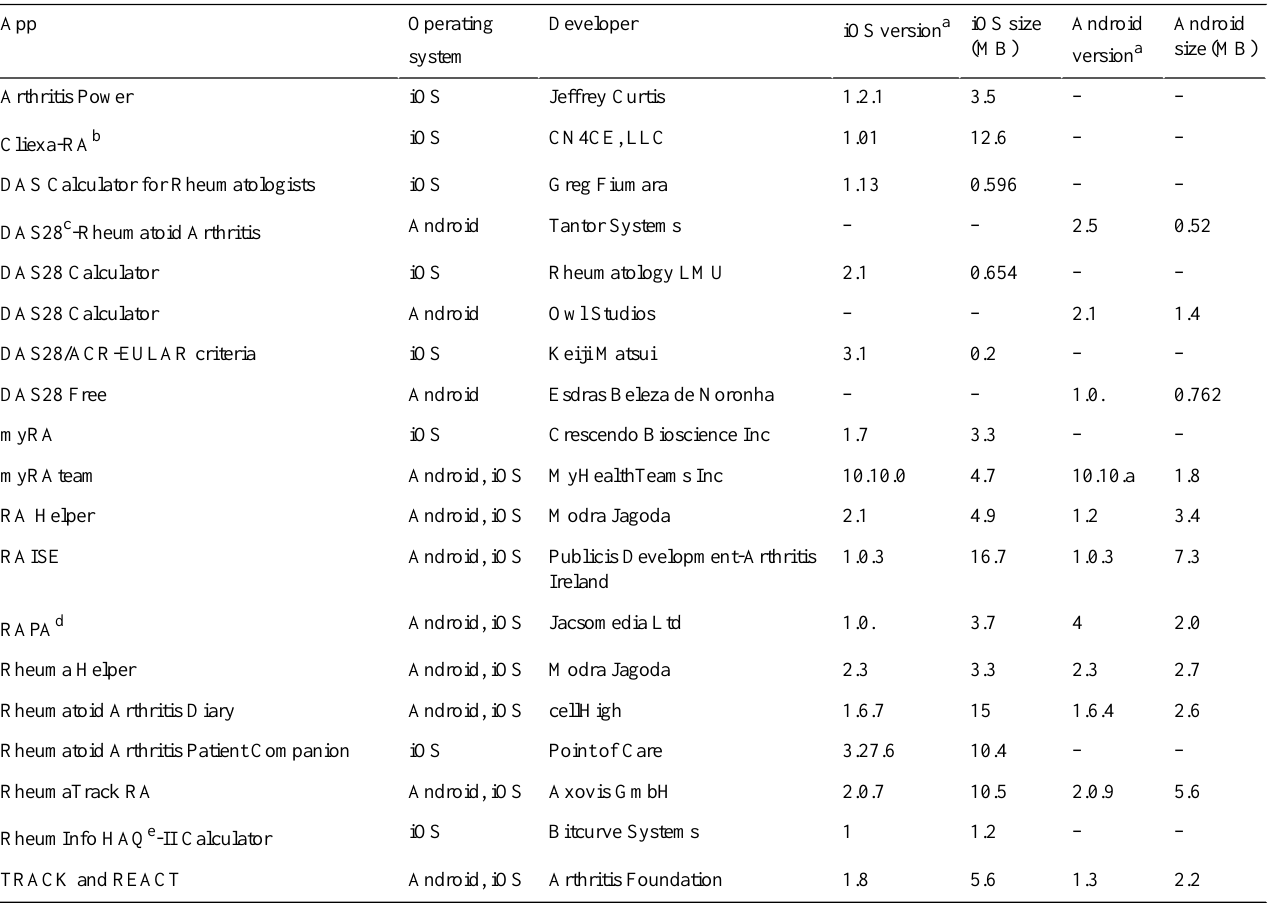
Table 2. Operating system, developer, version, and size of included